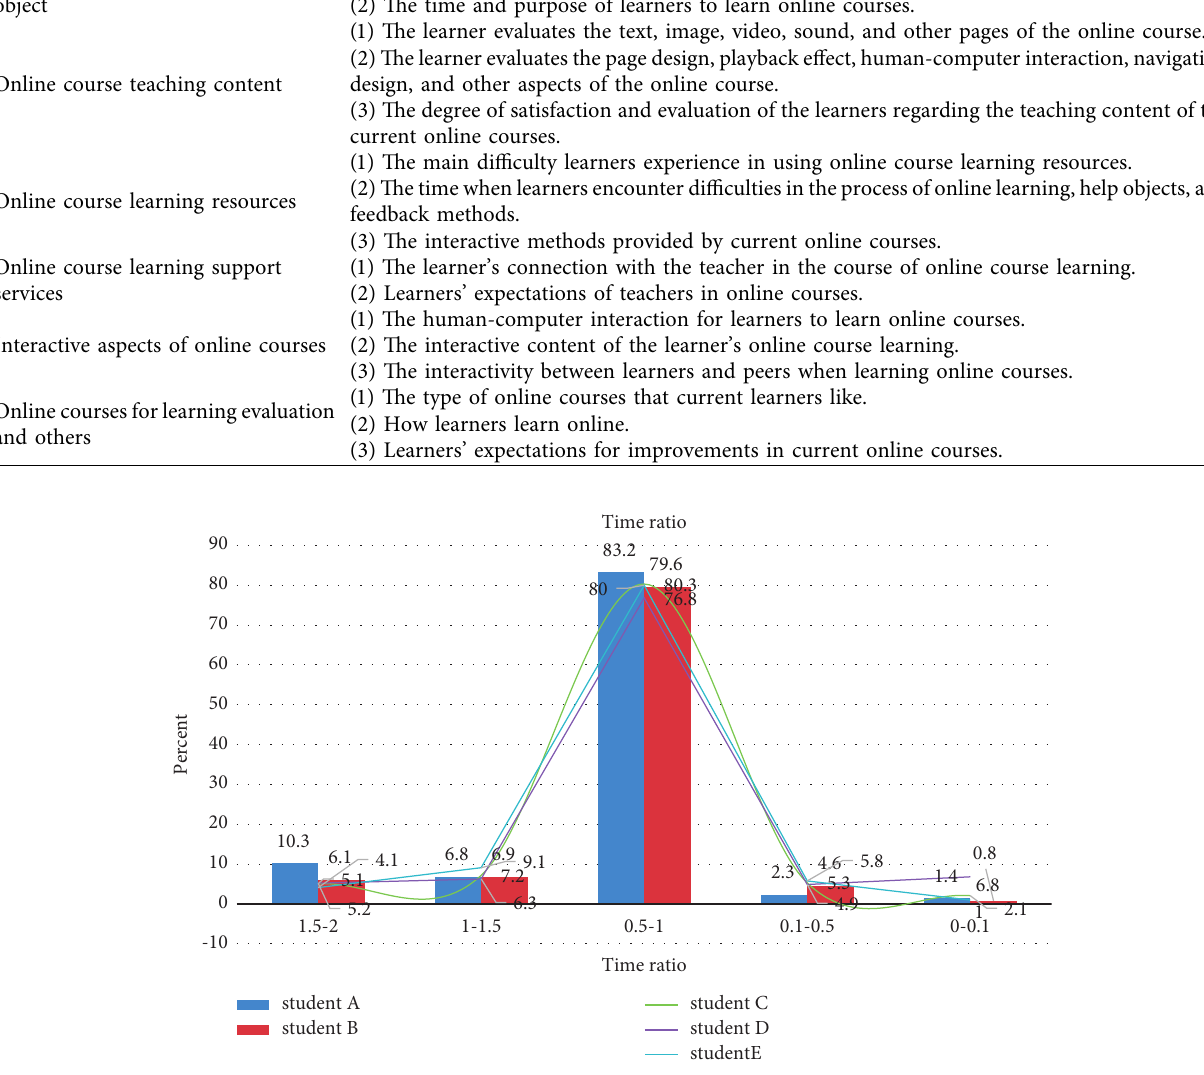
Figure 2: Finding out how long learners spend during online courses. Table 2: Interactivity of online